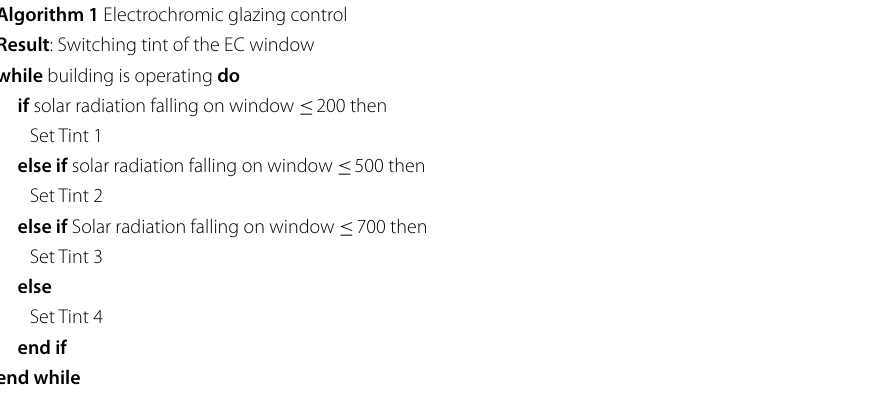
Algorithm 1 Electrochromic glazing